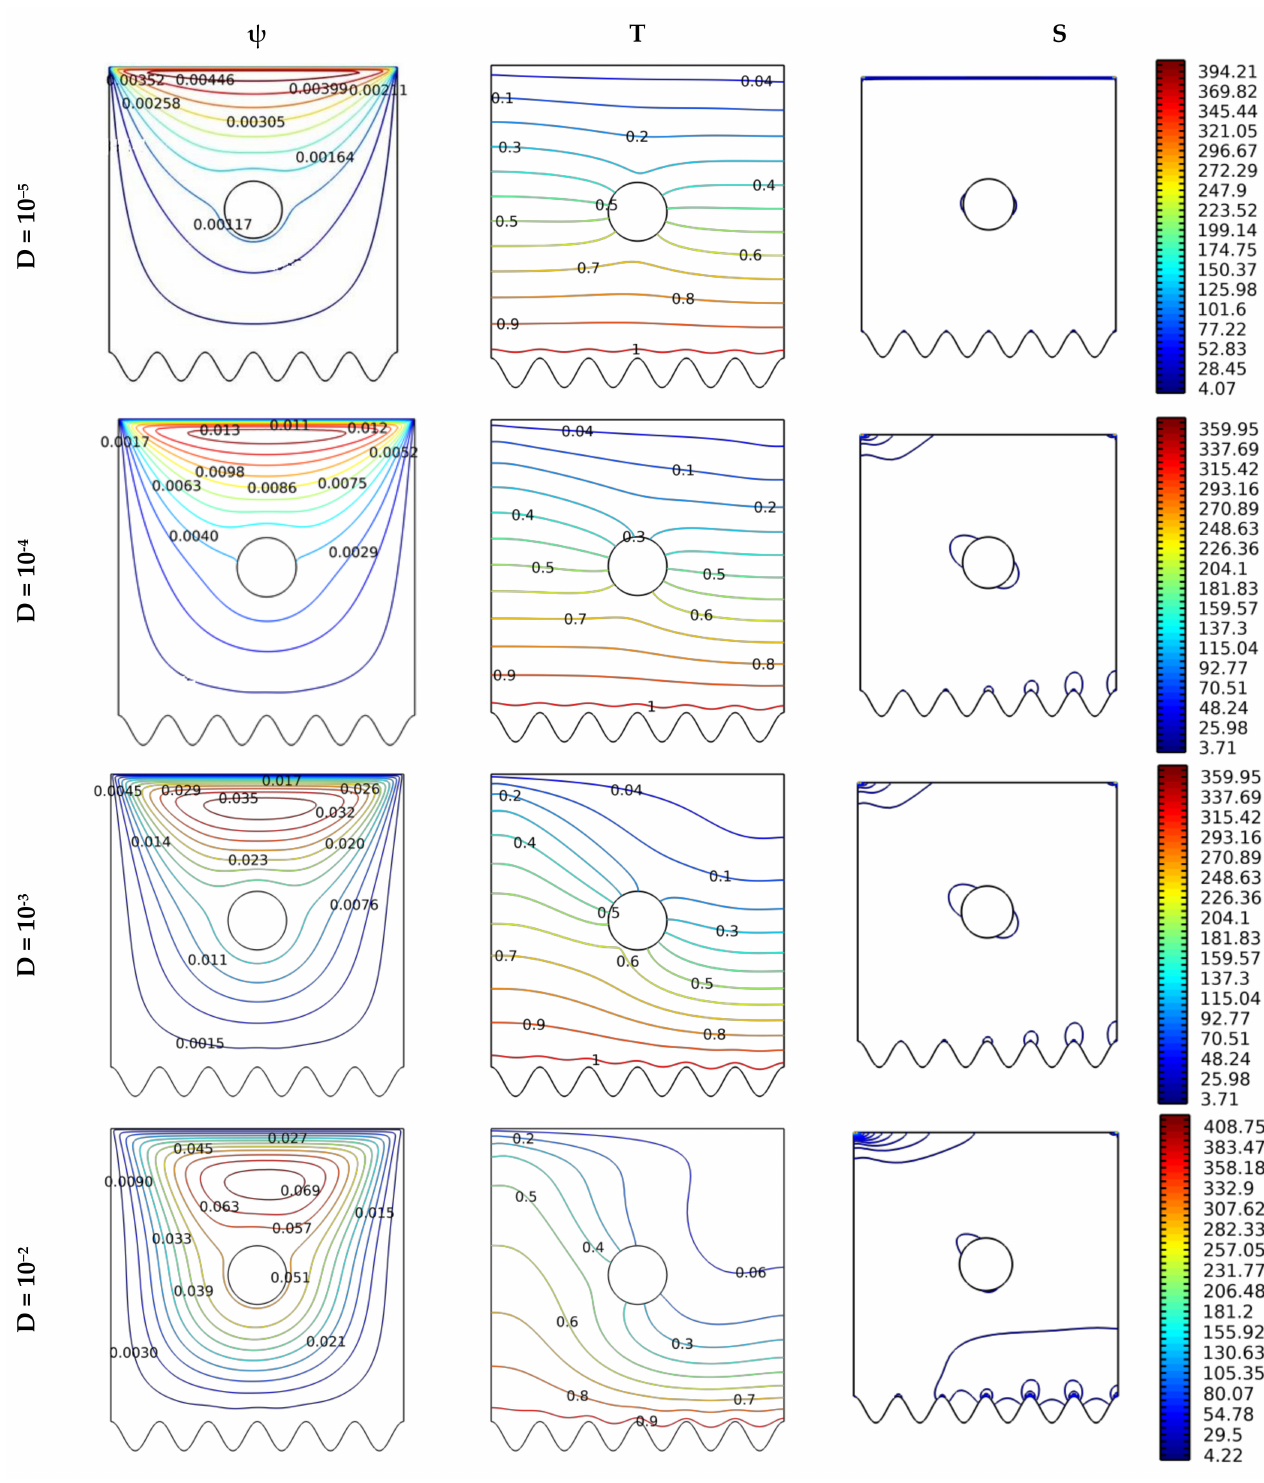
Figure 6. Distribution of streamlines, isotherms, and isentropic contours for various Darcy numbers Da at Gr = 10 3 , N = 8, and Ha =